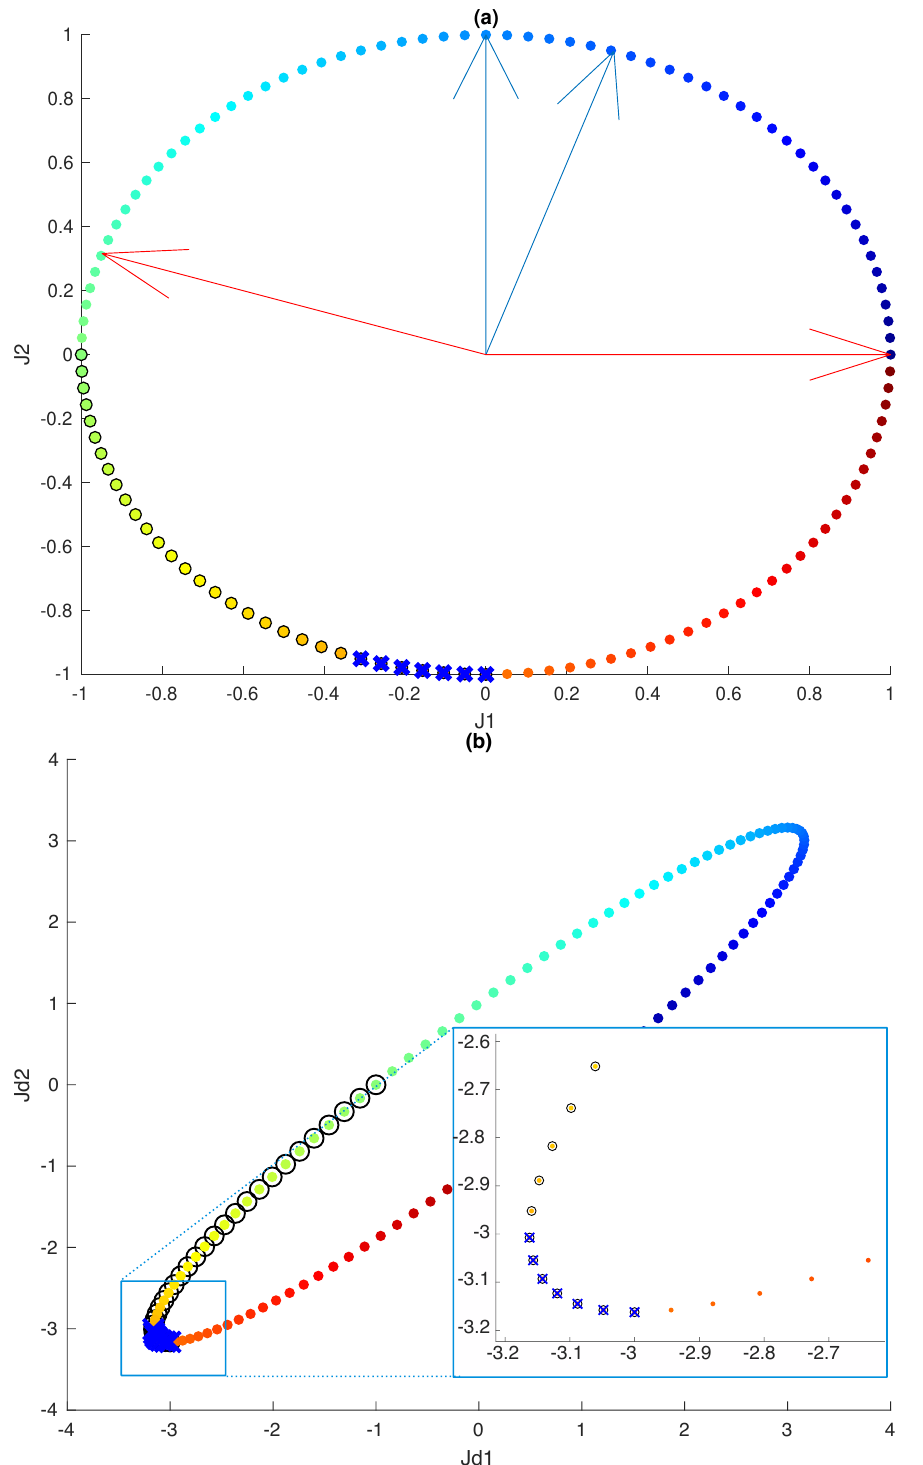
Figure 5. ( a ) Representation of the unit circle in the canonical basis, and the preference (red) and dominance (blue) vectors of the corresponding basis. Lines with ’o’ and ’x’ show Pareto front in canonical and basis, respectively. ( b ) Same circle and Pareto fronts drawn in B d Figure 5a also shows the vectors that correspond to the preferences base (in blue) and to the dominance base (in red). Note that Pareto front changes according to the base on which the points are represented. The points that correspond to an approximation of the front that would be obtained using the canonical base are highlighted with circles,